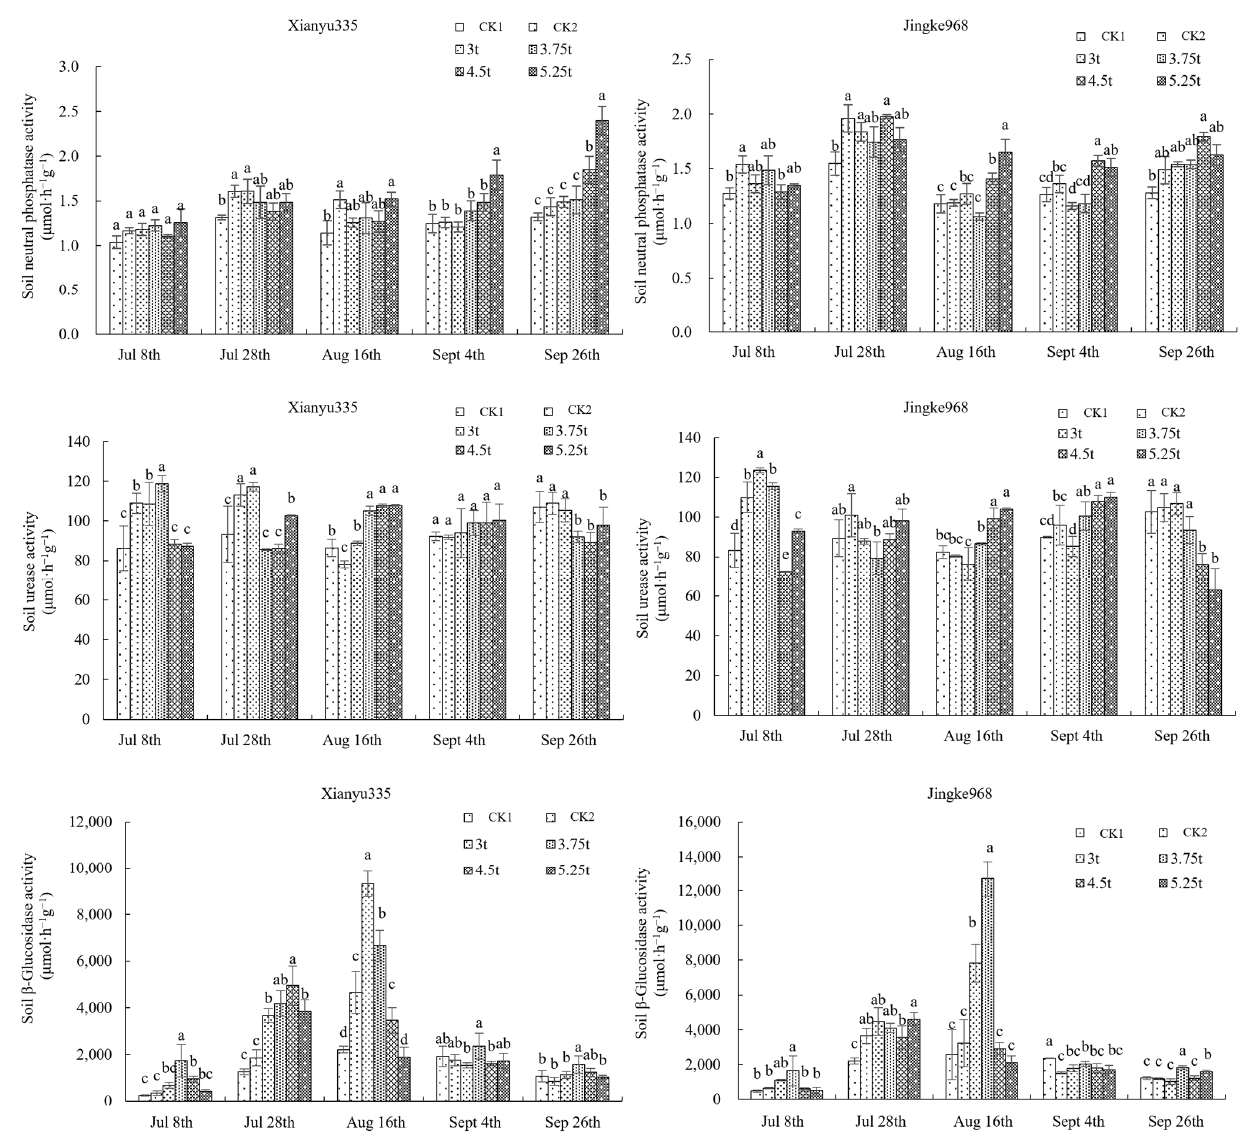
Figure 3. Effect of carbon-based fertilizer on the activities of neutral phosphatase, urease, and β - Glucosidase in soil. Notes: Different letters within the same column indicate significant difference at the 5% level.